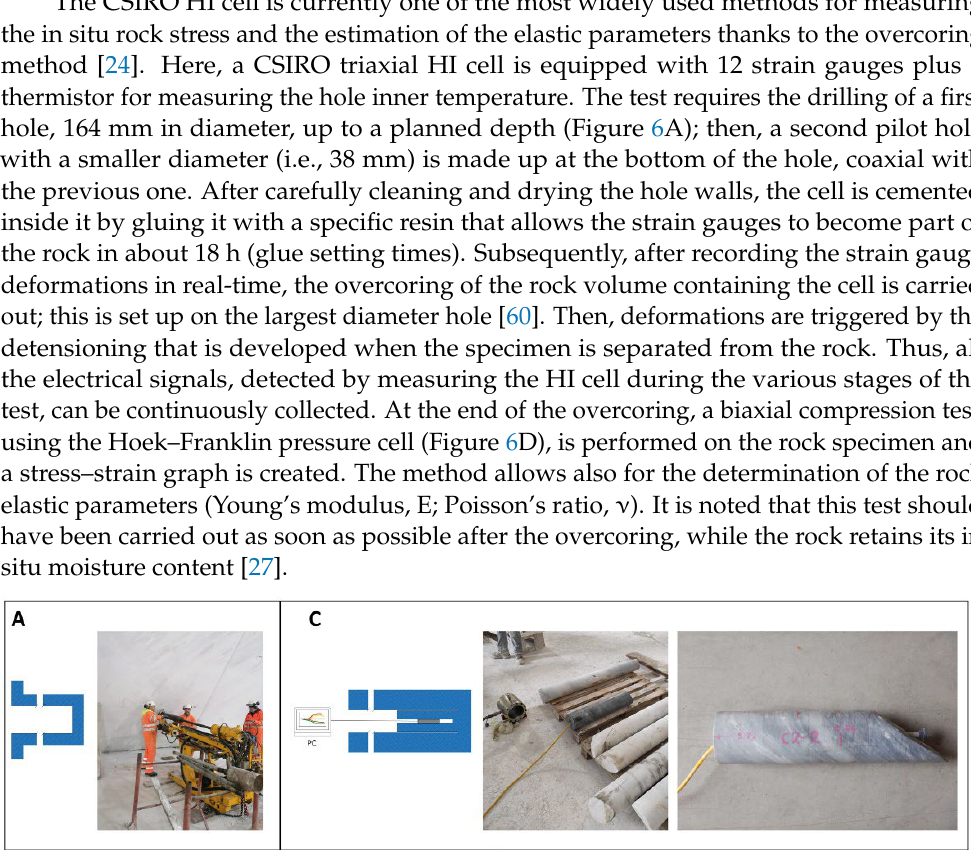
Figure 7. Planimetric view of the Sottovettolina quarry, location of the in situ stress measurements (C 1-1, C 1-2, C 2-1, and C 2-2), and exemplificative schematic section aimed at showing the borehole dip. The table on the right resumes the geometry of the tests. The output data provides, for each CSIRO HI cell, a real-time graph showing the trend of deformations [micro- strain, µε] versus the depth [cm]. Deformation data was cor- rected for temperature variation according to the C method [61] proposed by TRT (Top Rock Technologies). The relationship between the strain gauge deformations and the radial pressure comes from the linear solution proposed by [62,63], where the basic assumptions of the